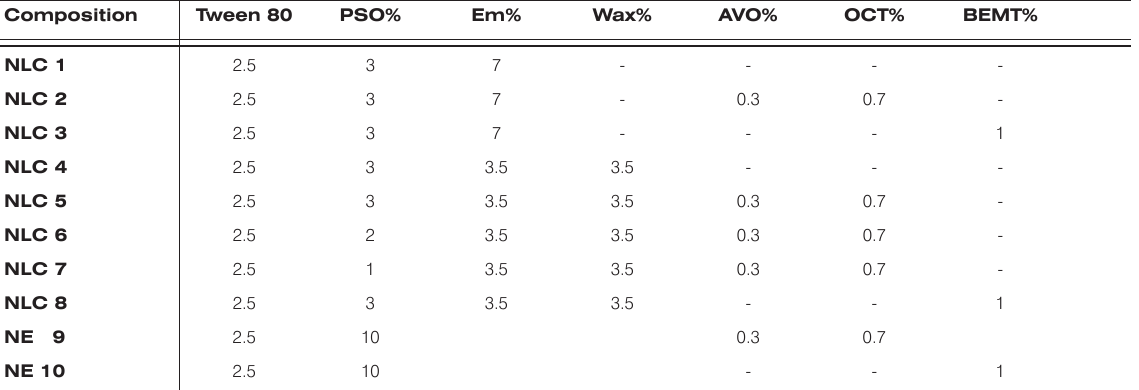
Table 1. Composition of NLCs loaded with UV filters.